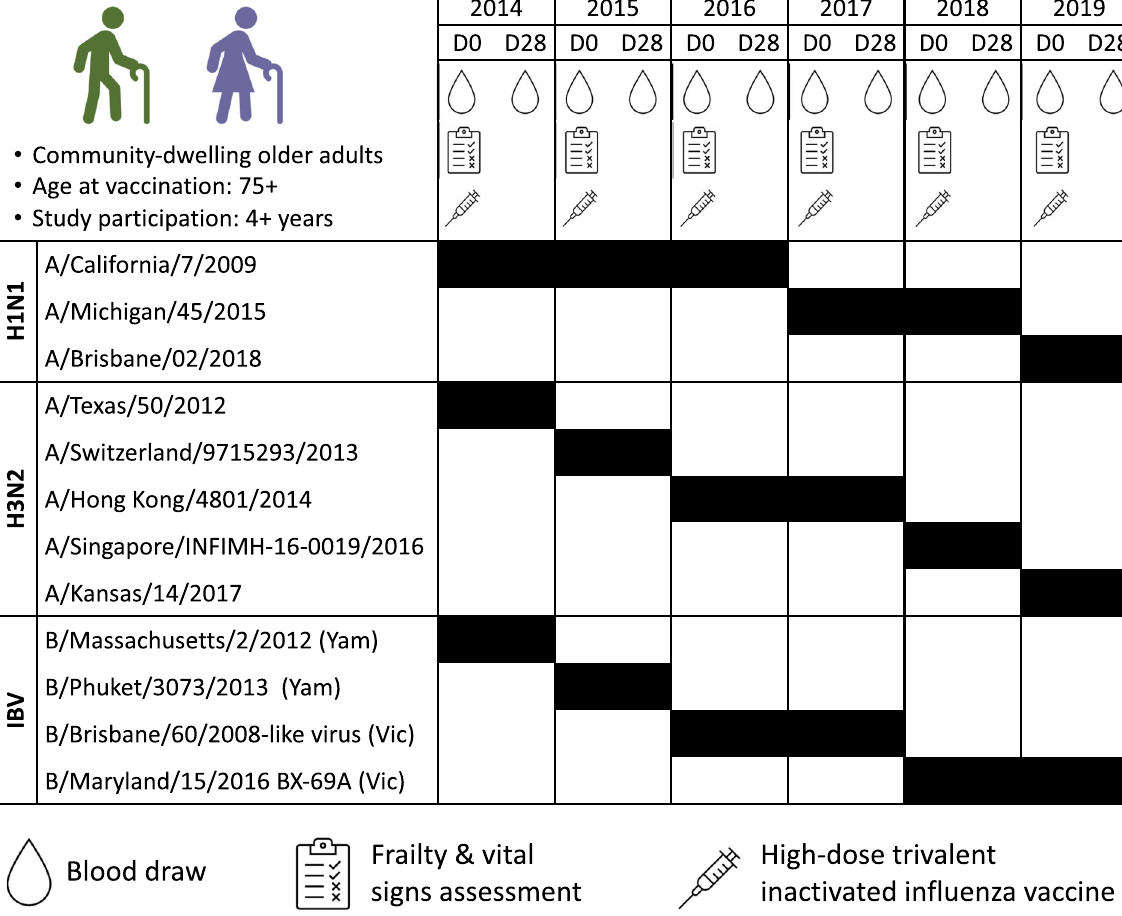
Fig. 1 Study design. Study procedures and the three strains included in each seasonal HD-IIV3 are shown. Serum from blood draws was used to evaluate pre- and post-vaccination strain-speci fi c hemagglutination antibody inhibition (HAI) titers, and frailty was assessed using the Frailty Phenotype. Images were created with